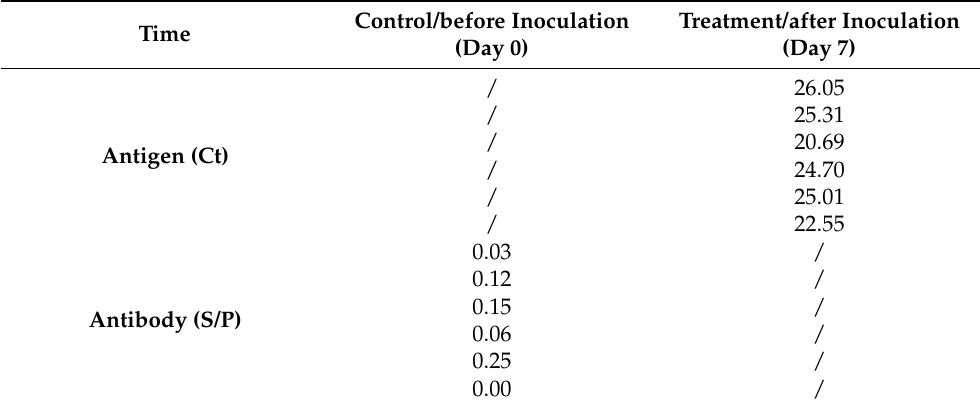
Table 1. Antigen and antibody of (day 0) and (day 7) with challenge virus.